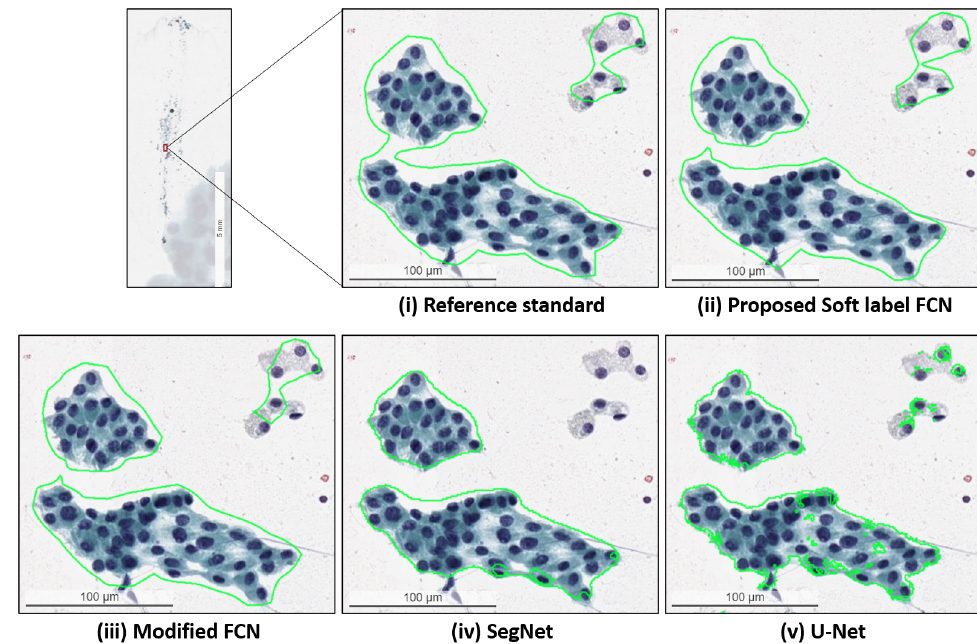
Figure 8. Qualitative segmentation results of the proposed SL-FCN method and the baseline methods for segmentation of PTC in Papanicolaou-stained